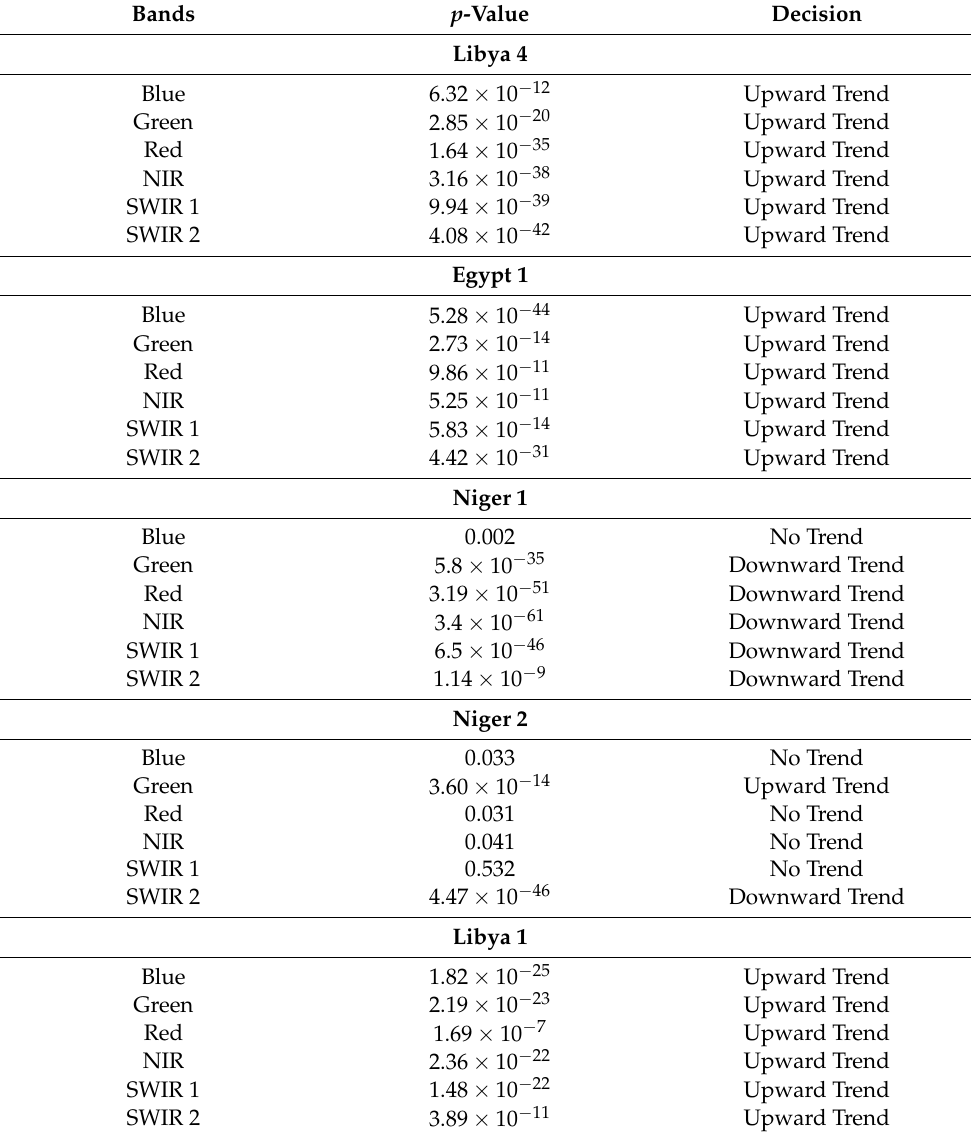
Table 14. Summary of Mann–Kendall test results for overall time series for Libya 1, Egypt 1, Niger 1, Niger 2 and Libya